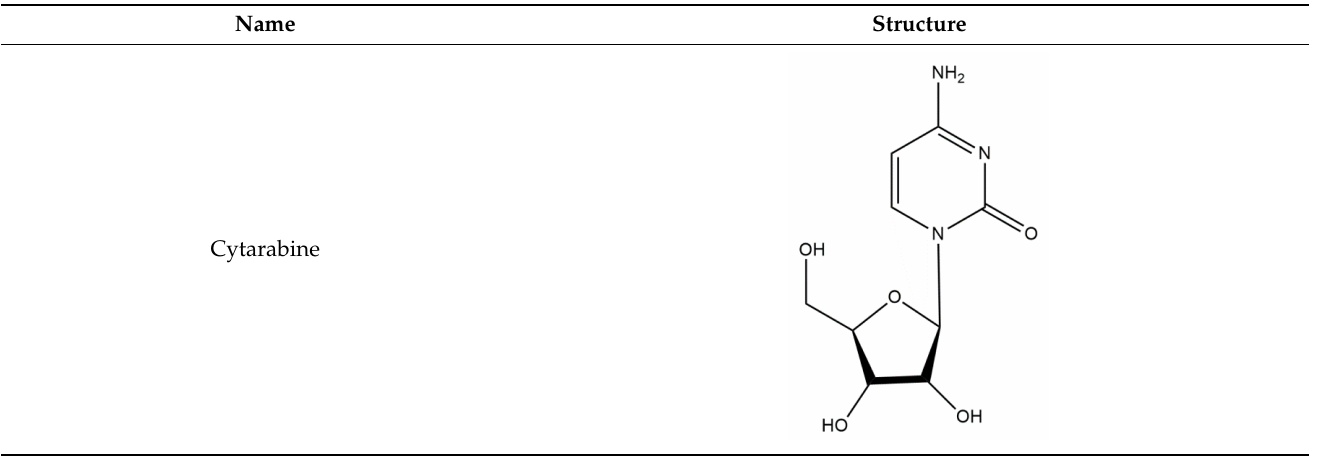
Table 1. The below table lists the marine drugs used in cancer treatment and their respective